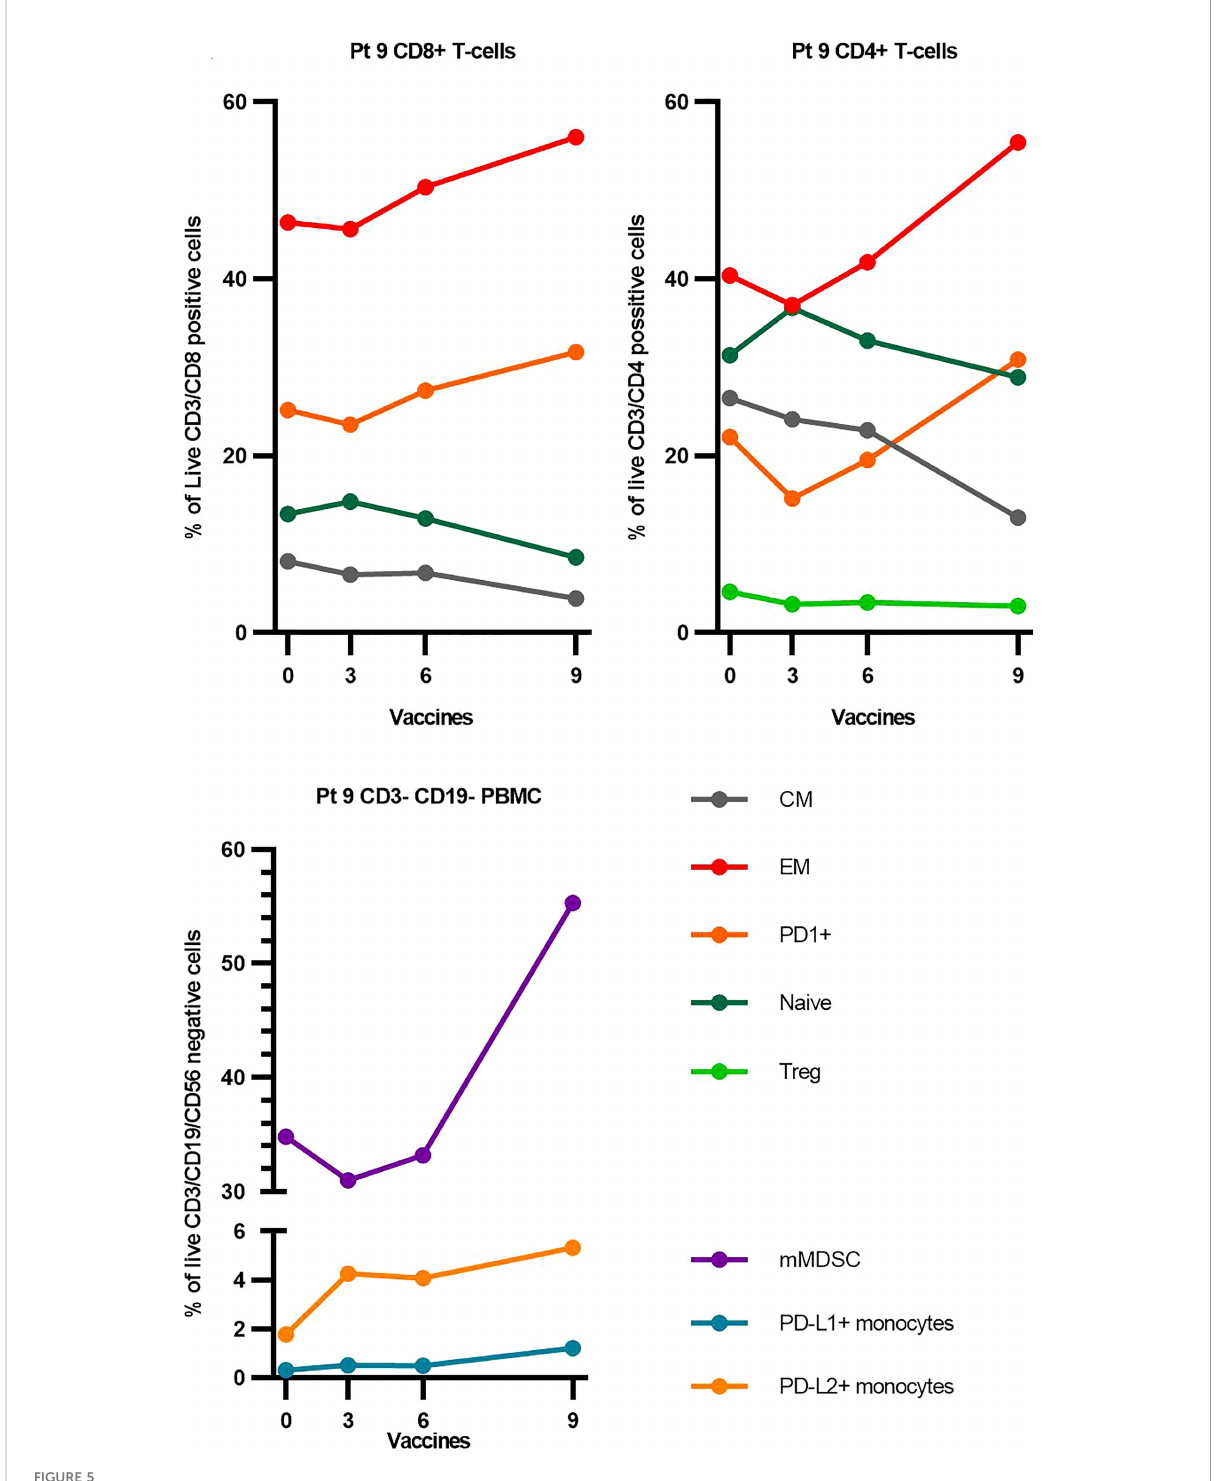
FIGURE 5 Changes in selected immune subsets for Pt9. For a detailed gating strategy, see Supplementary Figure 3. EM, effector memory; CM, central memory; Treg, regulatory T cells; PBMCs, peripheral blood mononuclear cells; mMDSC, monocytic Myeloid Derived Suppressor